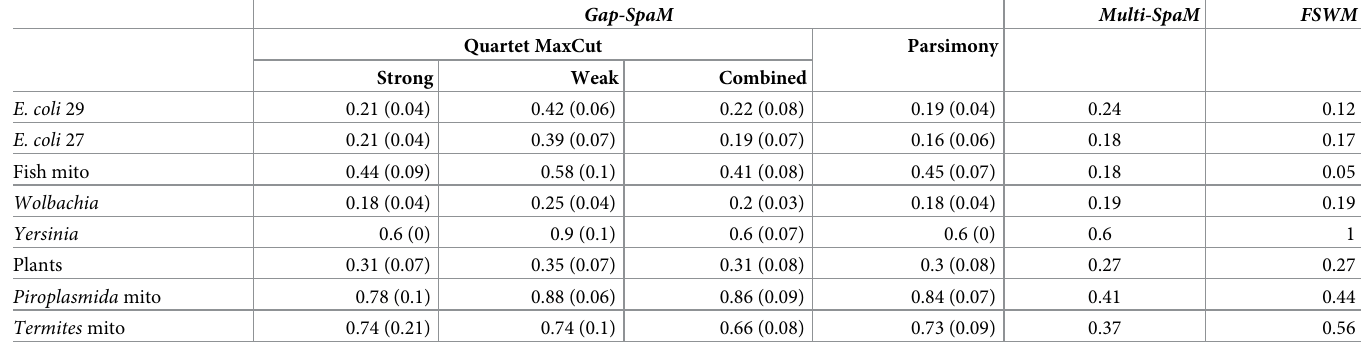
Table 3. Average normalized Robinson-Foulds (RF) distances between trees, reconstructed with various alignment-free methods, for the genome sets listed in Table 2. For each data sets, we performed 10 program runs with our indel-based approach. The average over these program runs is shown in the table; standard deviations are shown in parentheses.